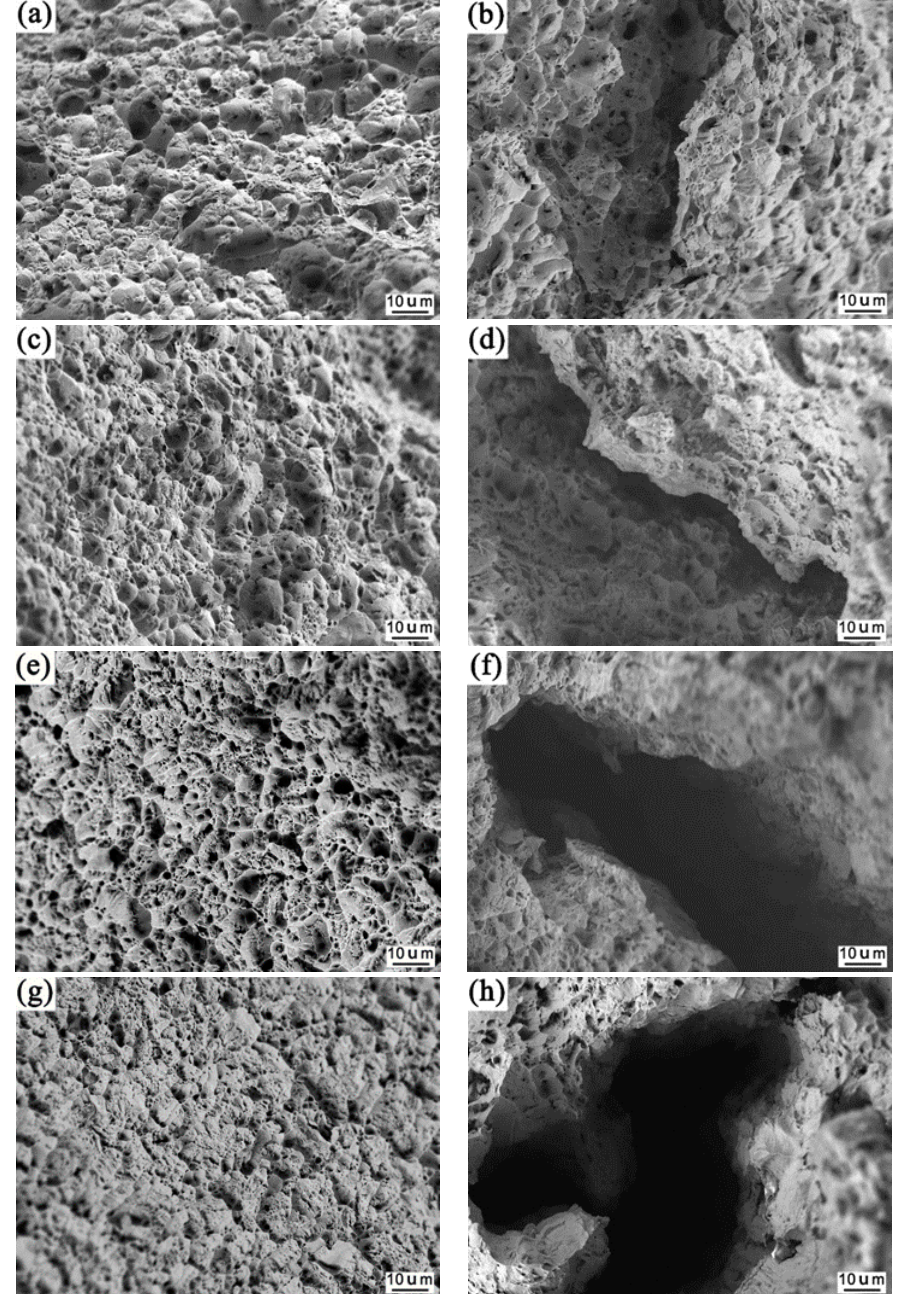
Figure 10. SEM morphologies of tensile fracture surface edges of the bars drawn by ( a ), ( c ), ( e ) and ( g ) ECD, and ( b ), ( d ), ( f ) and ( h ) DIA for ( a ), ( b ) 1; ( c ), ( d ) 3; ( e ), ( f ) 5 and ( g ), ( h ) 7 passes.